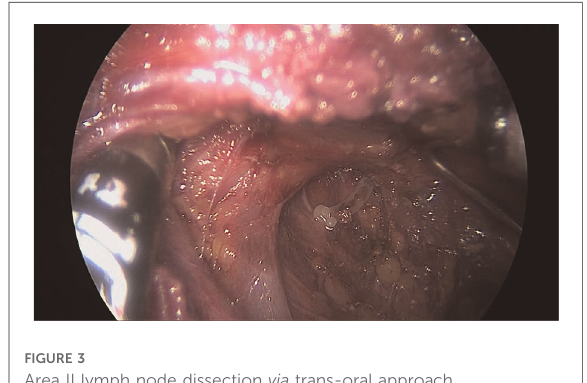
FIGURE 3 Area II lymph node dissection via trans-oral approach.